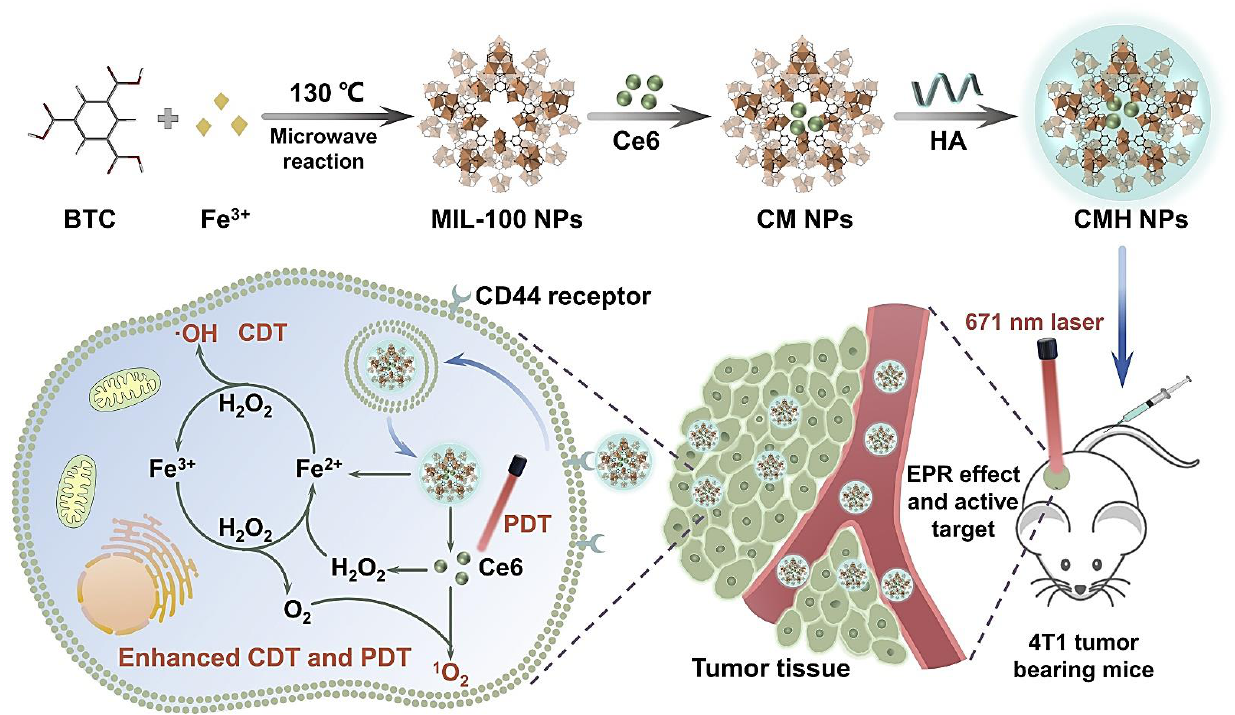
Figure 5. Schematic illustration of CMH NPs for synergetic chemo-photodynamic tumor therapy. Image was reproduced with permission from reference [69].